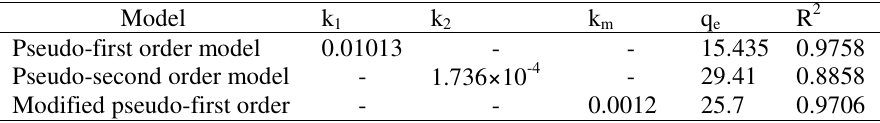
Table 2. Parameters of kinetic